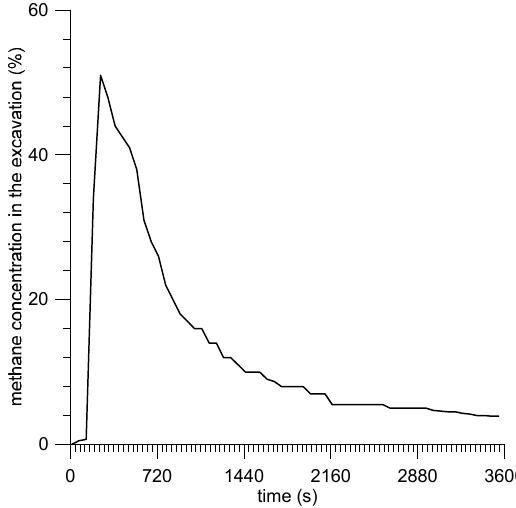
Figure 22. Methane concentration in the excavation after Zofiówka outburst.